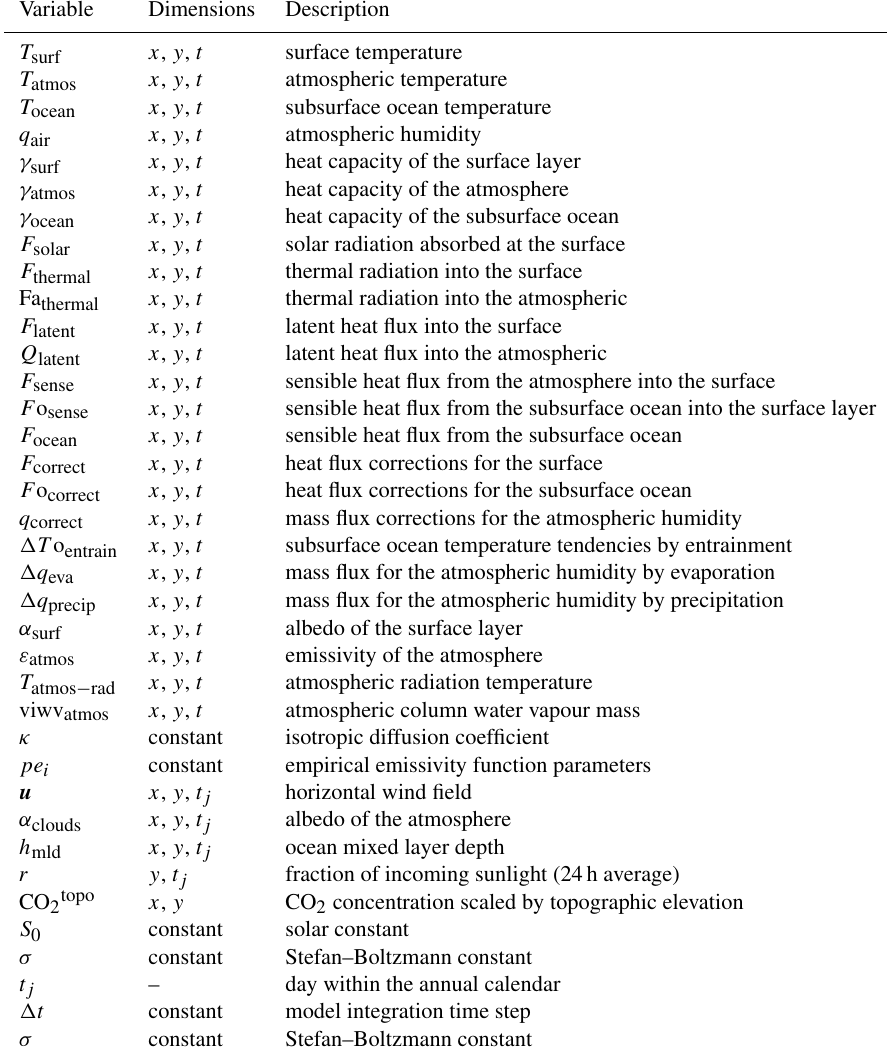
Table A1. Variables of the GREB model